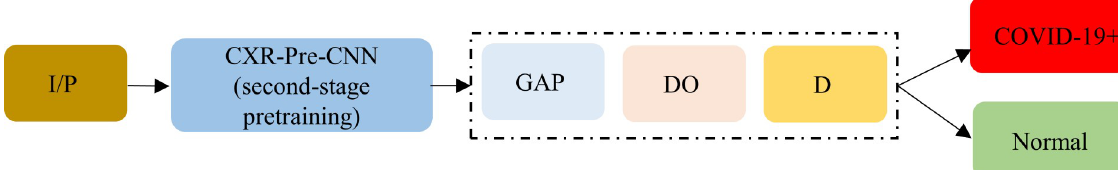
Fig 7. The architecture of the CNNs fine-tuned toward COVID-19 detection. I/P = Input, CXR-Pre-CNN = CXR-pretrained CNNs from the second stage of pretraining, truncated at their deepest convolutional layer, GAP = Global Average Pooling, DO = Dropout, D = Final dense layer with Softmax